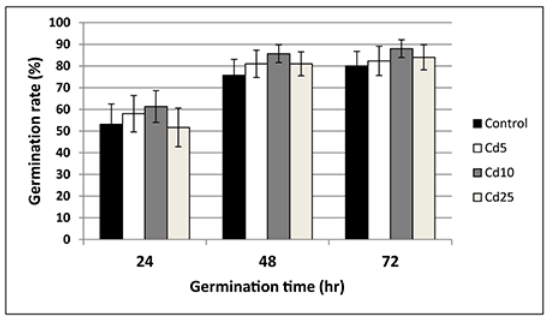
Figure 5 Germination rate of control seeds (black bars) and seeds preincubated in Cd solutions with Cd at concentration 5 mg/L (white bars), 10 mg/L (grey bars), and 25 mg/L (creamy bars)measured after 24, 48, and 72 hr. The results are means of six independent repetitions ± SE . No significant differences were